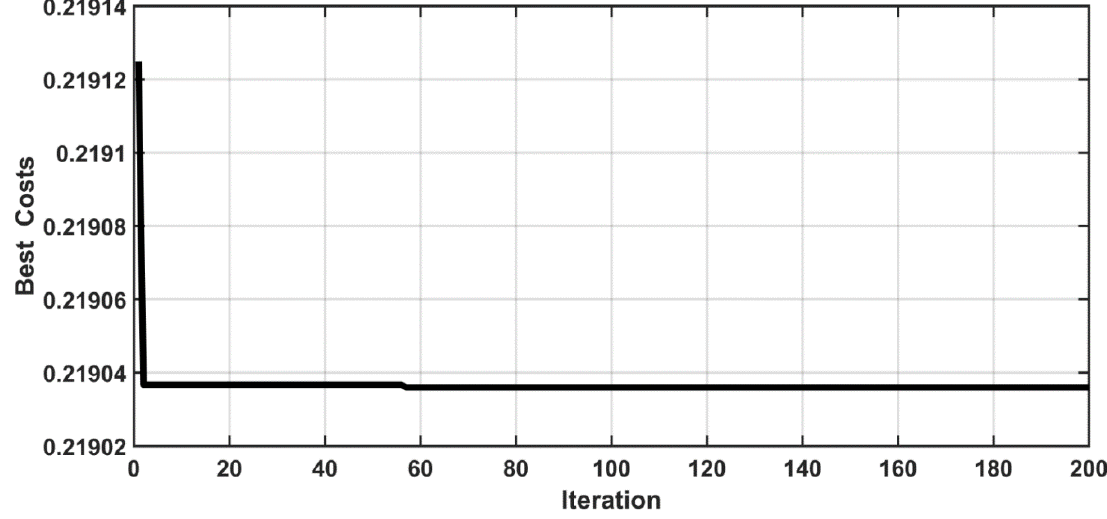
11 of 20 Table 2. Non-Optimal and Optimal settings of ASC and CSC parameters. Controller